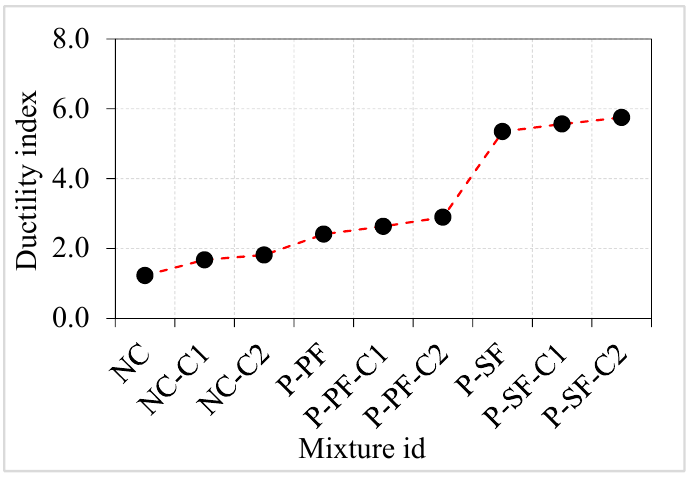
Figure 16. Ductility index.